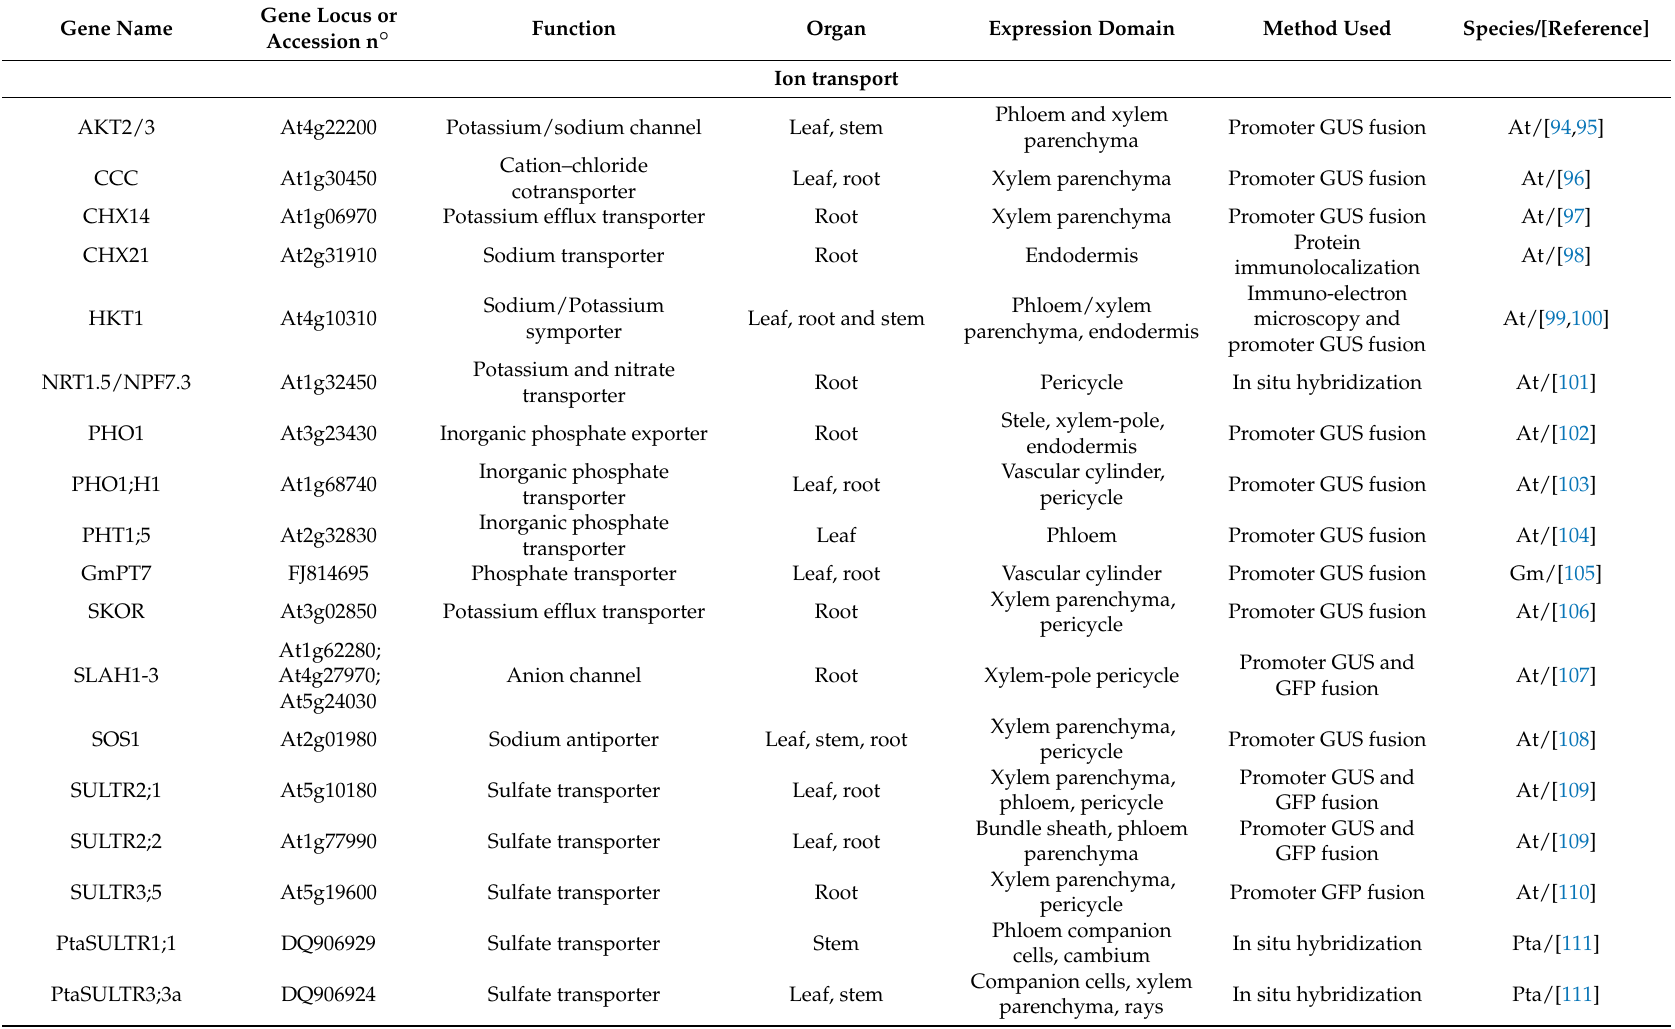
Table 2. Plasma membrane solute transporters showing a localization in vascular or perivascular cells in dicotyledonous